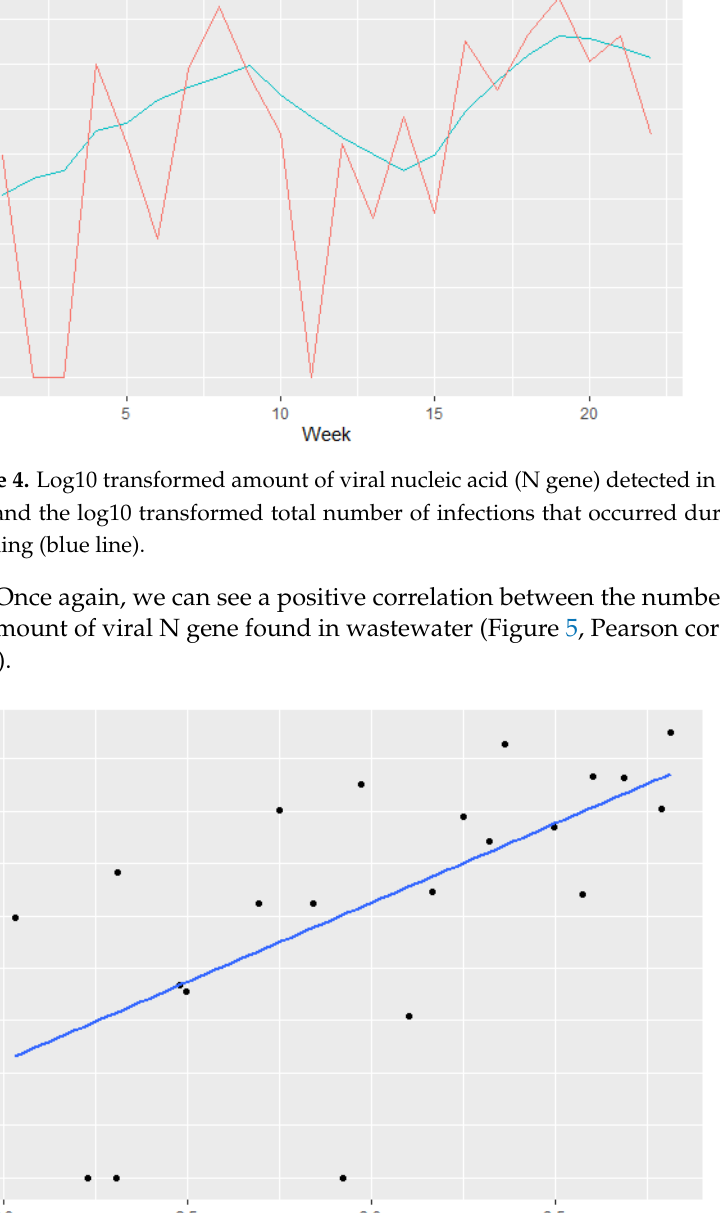
Figure 3. Correlation between the log10 transformed number of infections three days from the sampling day and the log10 transformed amount of virus detected in WWTP influent (Pearson correlation = 0.621).